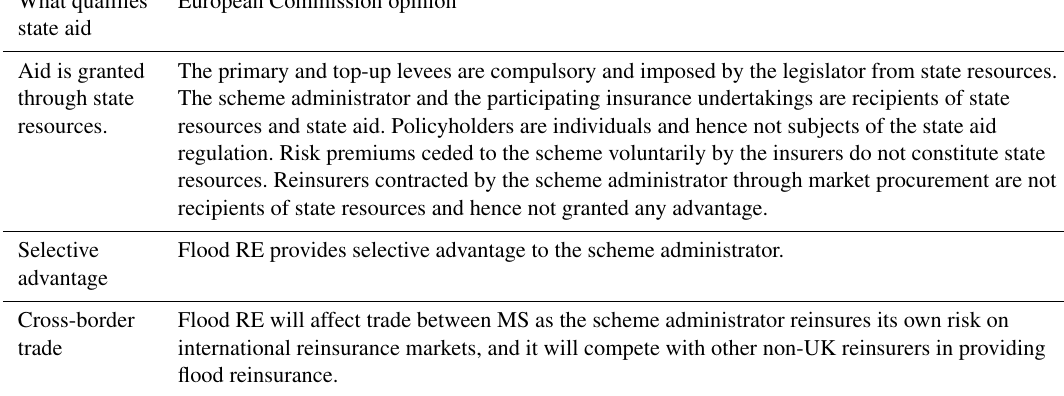
Table 2. Summary of the European Commission’s findings under the review of the Flood RE scheme. The EC’s decision text (EC, 2015) can be consulted through the link provided in the reference list.